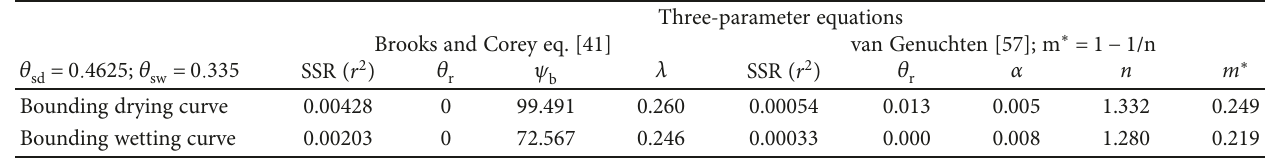
Table 2: Best- fi t parameters and SSR values for the two- and three-parameter equations: the Brooks and Corey [41], van Genuchten [57], and Fredlund and Xing [58] equations.